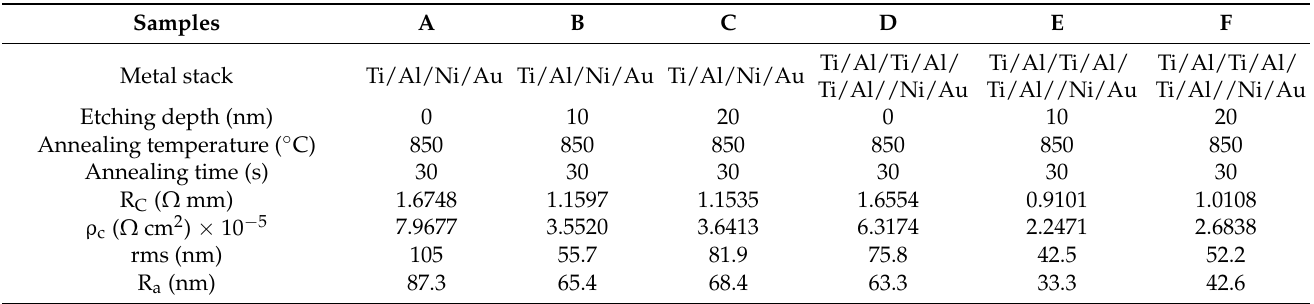
Table 9. Summary of data based on six samples annealed at 850 °C. Reproduced under terms of the CC-BY license [244]. Copyright 2021, Zhu et al., published by AIP Publishing.